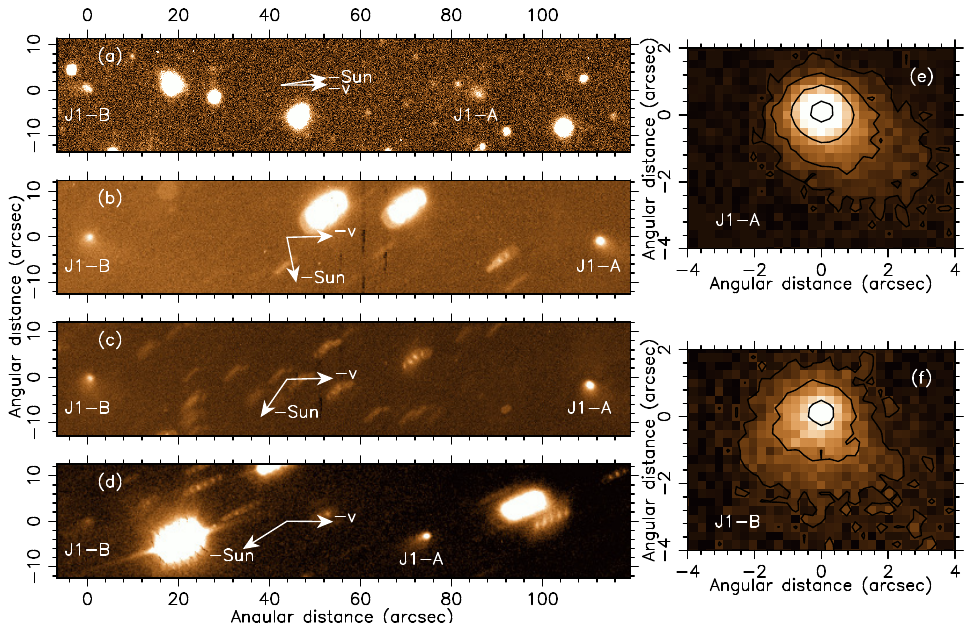
Figure 8. Images of the two components, P/2016 J1-A and J1-B, obtained with MegaCam on the 3.6 m Gran Telescopio Canarias on 15 May 2016, 29 May 2016, and 31 July 2016 ( b – d ). In panels ( a – d ), the physical dimensions are 170,982 × 33,925, 133,788 × 26,545, 135,616 × 26,908, and 184,964 × 36,699 km, respectively. Close-up views of J1-A and J1-B on May 15, 2016 are shown on panels ( e , f ), respectively. North is up, and east is to the left in all panels. In panels ( a – d ), the projected directions opposite to the Sun and the negative of the orbital velocity vectors are shown. Adapted from